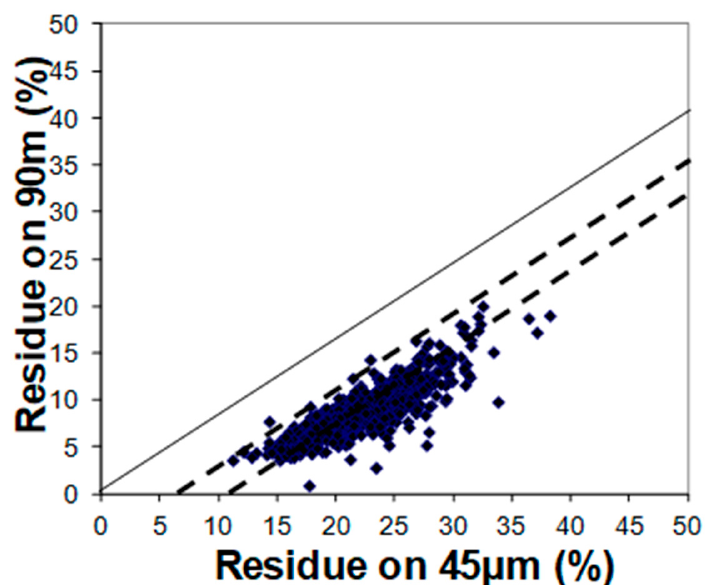
Figure 7. Relationship between the coal fly ash retained on the 45 µm and 90 µm mesh sieves, calculated from 765 spot samples picked in a period of ten years.